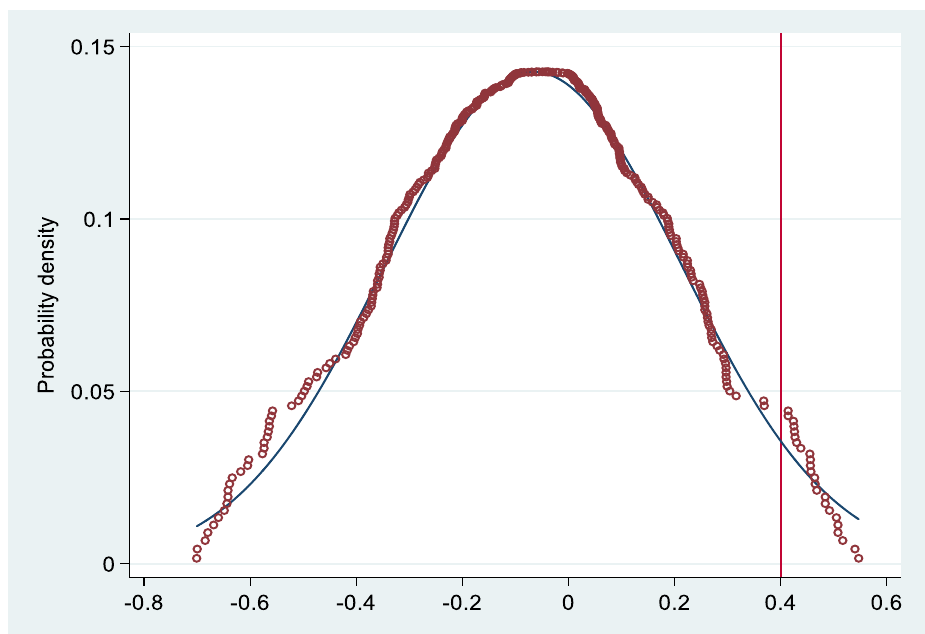
Figure 2. Parallel trend test.